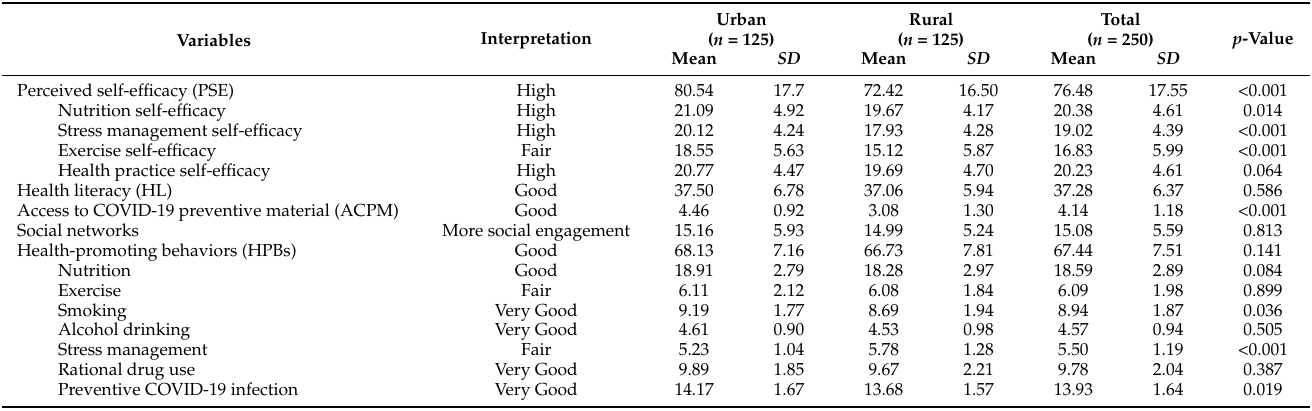
Table 2. Perceived self-efficacy, health literacy, access to COVID-19 preventive material, social networks, and health-promoting behaviors among urban and rural older adults with NCDs.